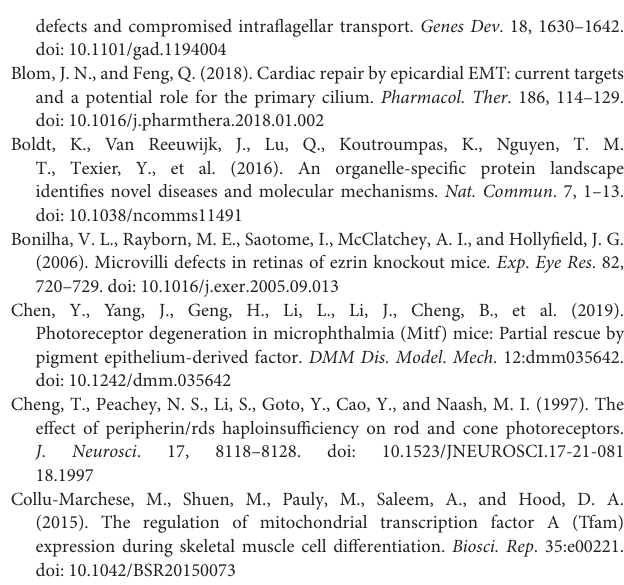
Supplementary Table 1 | Differentially expressed genes (DEGs) significantly regulated at P11. Significance defined by using False Discovery Rate (FDR) < 0.05 as threshold. 290 genes induced in red, and 302 inhibited in green. Supplementary Table 2 | Differentially expressed genes (DEGs) significantly regulated at P29. Significance defined by using False Discovery Rate (FDR) < 0.05 as threshold. 1,056 genes induced in red; and 1220 inhibited in green. Supplementary Table 3 | Comparison of differentially expressed genes (DEGs) between Bbs8 − / − and control with RPE-specific gene lists. Supplementary Table 4 | Gene Ontology enrichment analysis of the differentially expressed genes (DEGs) between Bbs8 − / − and control at P11. The Biological Process (BP_FAT) terms enriched among the down-regulated ( n = 302) and up-regulated ( n = 290) genes are highlighted in green (A) and red (B), respectively. For each BP annotation cluster, the GO identifier (“GO:”), associated term (“Term”) and Enrichment score are provided. The genes belonging to each term are listed in column D (and their total number in column C under “count”). False Discovery Rate score (FDR) is shown in column E. Supplementary Table 5 | Gene Ontology enrichment analysis of the differentially expressed genes (DEGs) between Bbs8-/- and control at P29. The Biological Process (BP_FAT) terms enriched among the down-regulated ( n = 1,220) and up-regulated ( n = 1,056) genes are highlighted in green (A) and red (B), respectively. For each BP annotation cluster, the GO identifier (“GO:”), associated term (“Term”) and Enrichment score are provided. The genes belonging to each term are listed in column D (and their total number in column C under “count”). False Discovery Rate score (FDR) is shown in column E. Supplementary Table 6 | Gene Ontology enrichment analysis of the differentially expressed genes (DEGs) resulting from the comparison of the two datasets at P11 and P29. The Biological Process (BP_FAT) terms enriched among the down-regulated genes in both datasets ( n = 33) and up-regulated in both datasets ( n = 32) genes are highlighted in green (A) and red (B), respectively. For each BP annotation cluster, the GO identifier (“GO:”), associated term (“Term”) and Enrichment score are provided. The genes belonging to each term are listed in column D (and their total number in column C under “count”). False Discovery Rate score (FDR) is shown in column